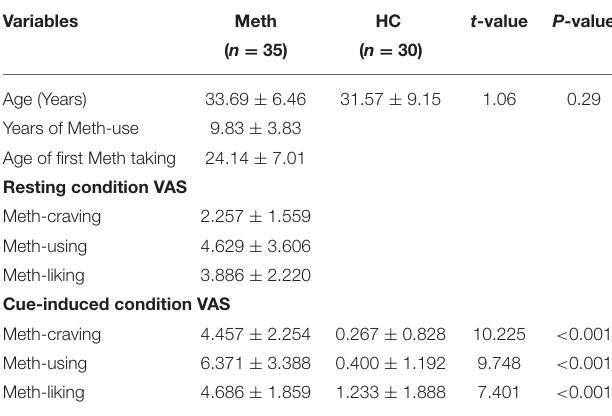
TABLE 1 | Demographic characteristics and VAS